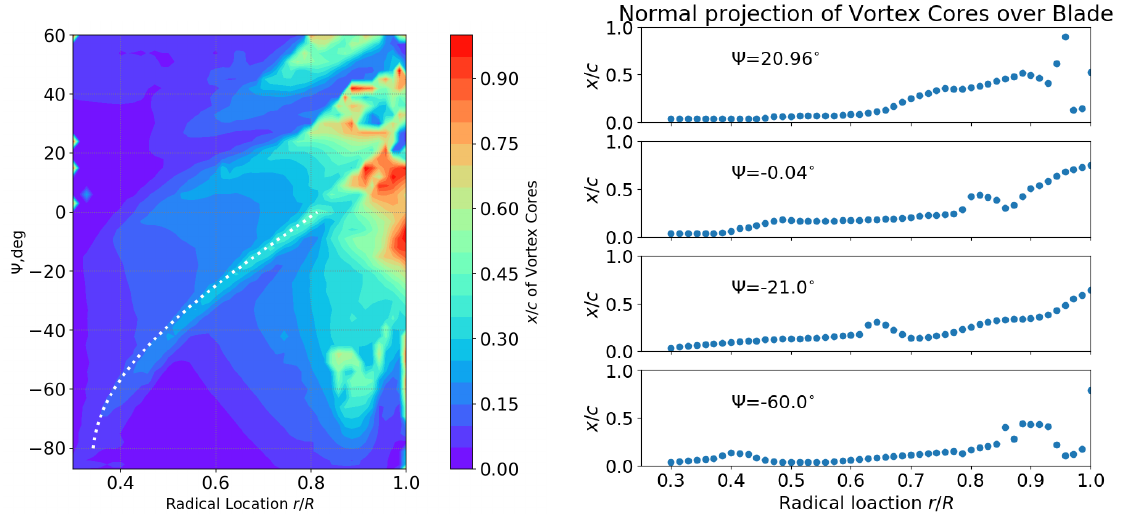
Figure 9. Left : Location of the vortex cores over the blade in radical region r / R = 0.3 ∼ 1.0 evolving along azimuth. Dotted line is a curve r / R = 1/2 × 0.248 ∆Ψ 2 + 0.16cos ( Ψ ) ∆Ψ + 0.3426, ∆Ψ in rad. Right : Projection of vortex cores on the blade upper surface at selected azimuths.